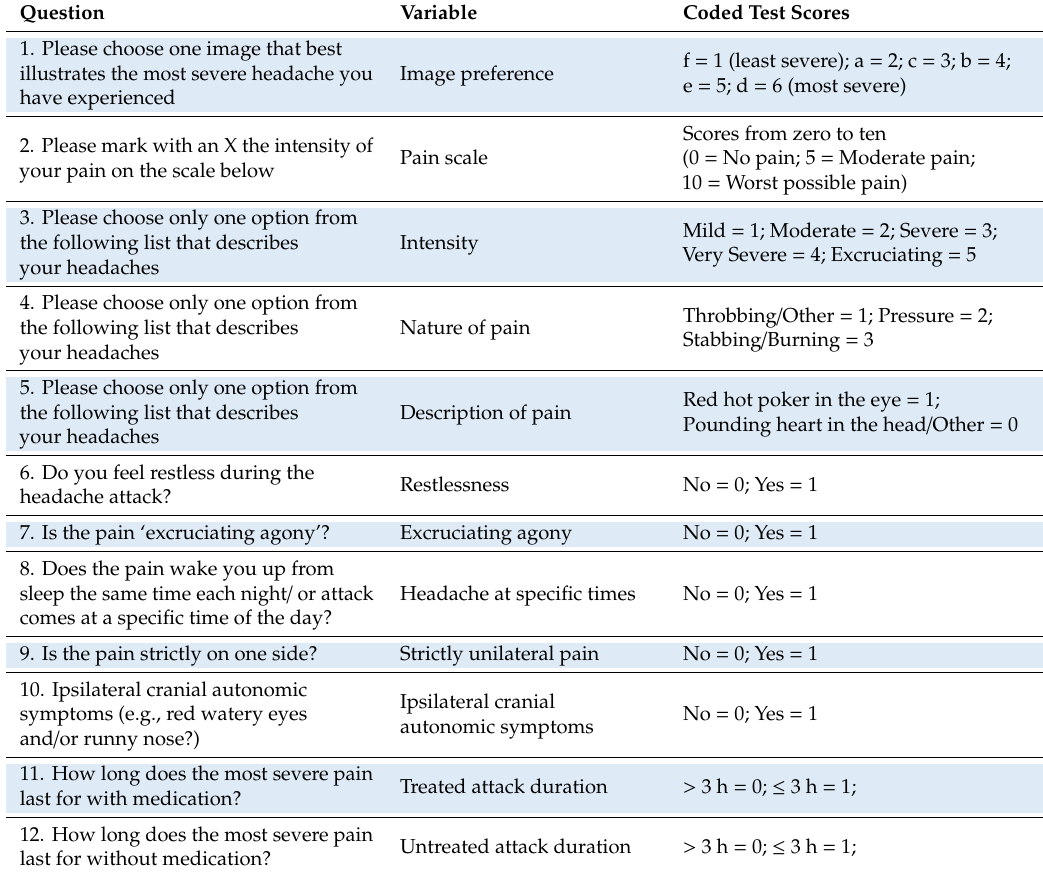
Table 1. Variables measured with the 12-item screening tool.